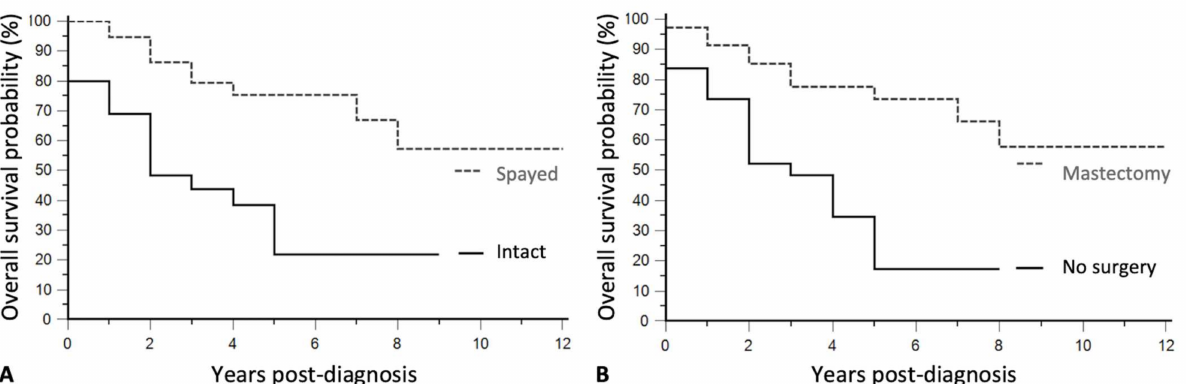
Figure 2. Kaplan-Meier survival curves of 84 female dogs with MTs according to the spaying status ( A ) and treatment modality ( B ). ( A ) The survival probabilities of the 39 spayed dogs with MTs (86% at 2 years post-diagnosis, grey line), were significantly better than those of the 45 intact female dogs (black line, 48% survival probability at 2 years post-diagnosis, HR = 0.28, 95% CI 0.14–0.55, p = 0.0001). ( B ) The survival probabilities of the 35 dogs with MTs that benefited from surgery (85% survival at 2 years post-diagnosis, grey line) were significantly better than those of the 49 dogs in which mastectomy was not performed (black line, 52% survival at 2 years post-diagnosis, HR = 0.31, 95% CI 0.16–0.62, p =